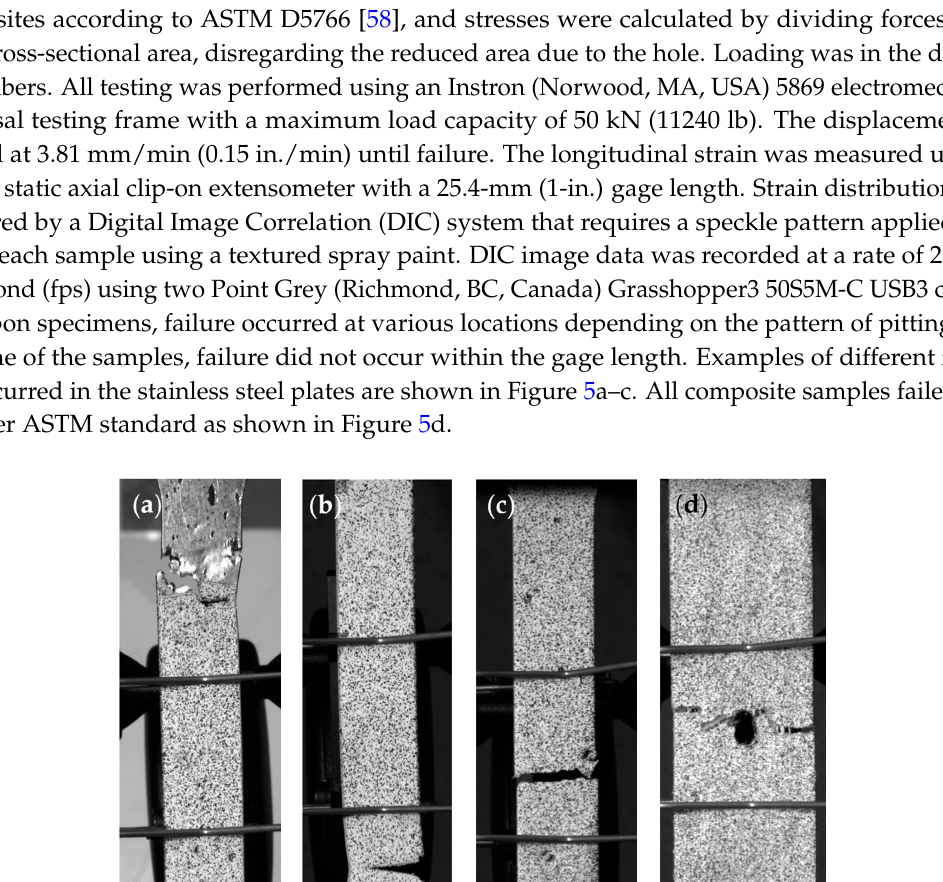
Figure 4. ( a ) Stacking sequence of the specimens; and ( b ) Submersion of the stacked